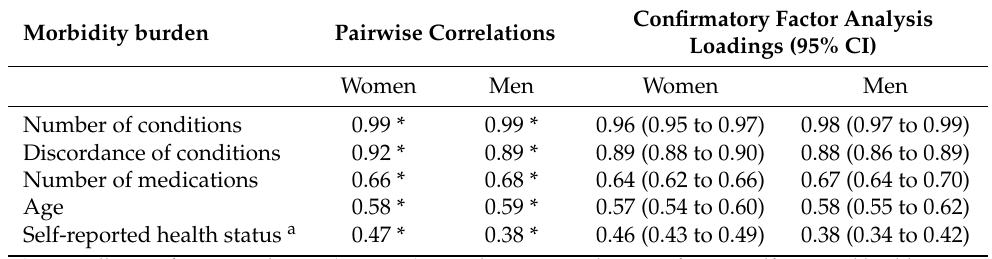
Table A1. Description of the morbidity burden latent variables: pairwise correlations between the proposed indicators and the latent variables and loadings in the confirmatory factor analysis.